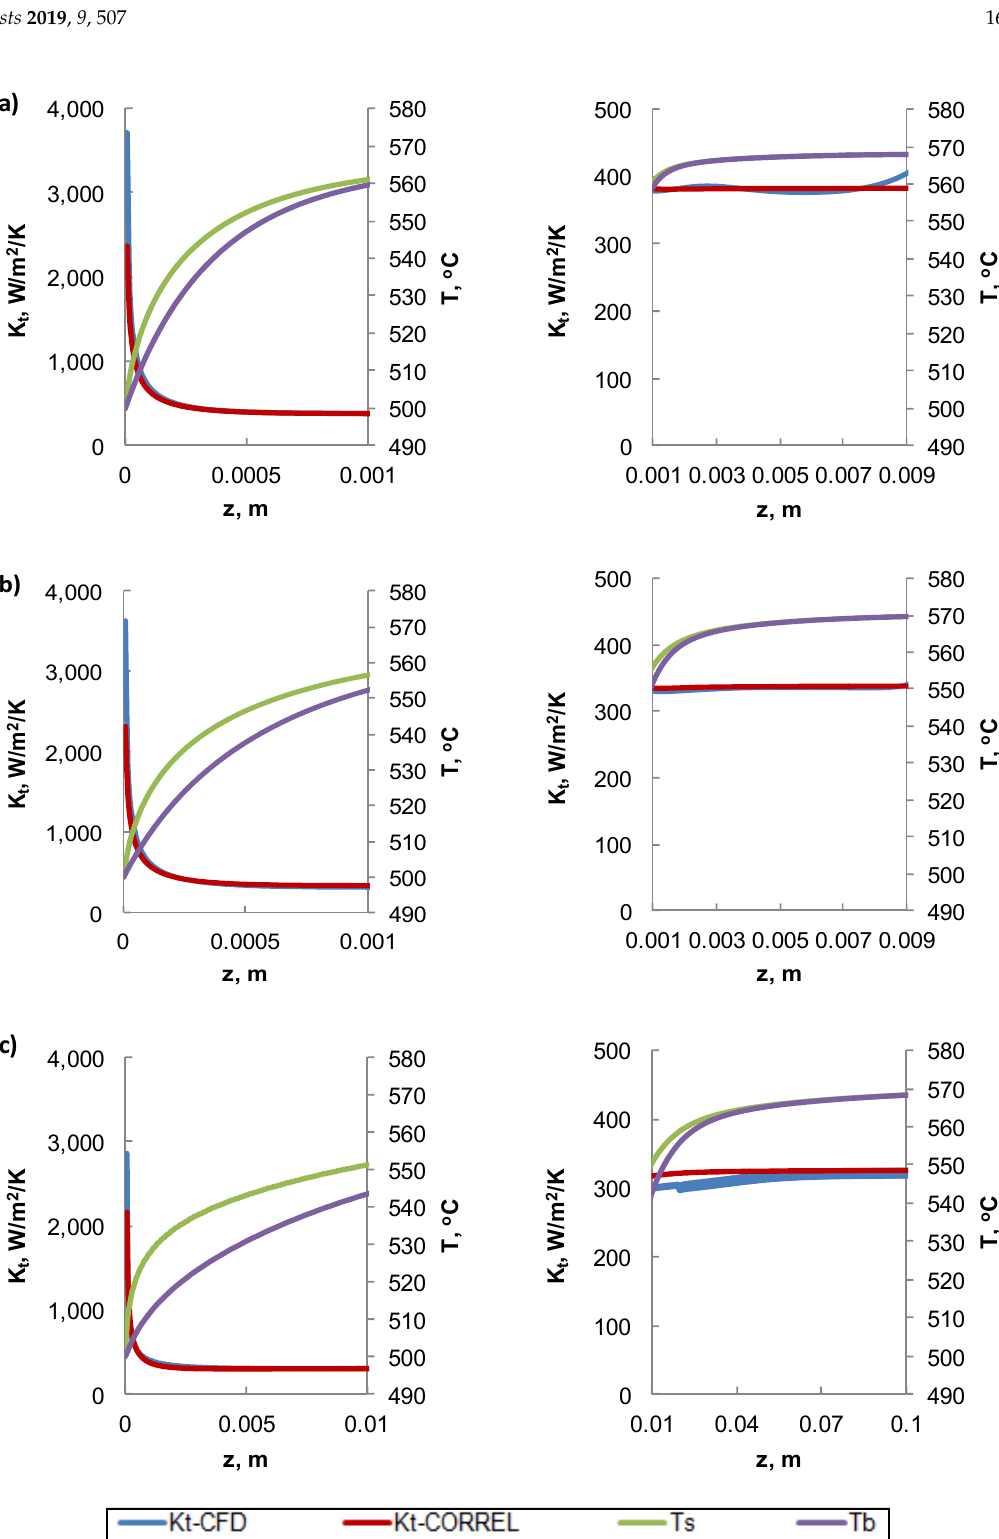
Figure 7. Representative figures for the comparison of K t profiles along the cell length predicted by the proposed correlation with those derived from CFD calculations as well as comparison of the temperature profile in the bulk of the gas phase and over the catalytic surface. Cell diameter d = 1.1 mm. Lean feed composition. Inlet temperature: 500 °C. ( a ) Inlet velocity 0.037 m/s. Re = 0.53, ( b ) inlet velocity 0.3 m/s. Re = 4.3, ( c ) inlet velocity 7.2 m/s. Re = 100. The average relative error of prediction for the heat transfer coefficients is 2.2%.